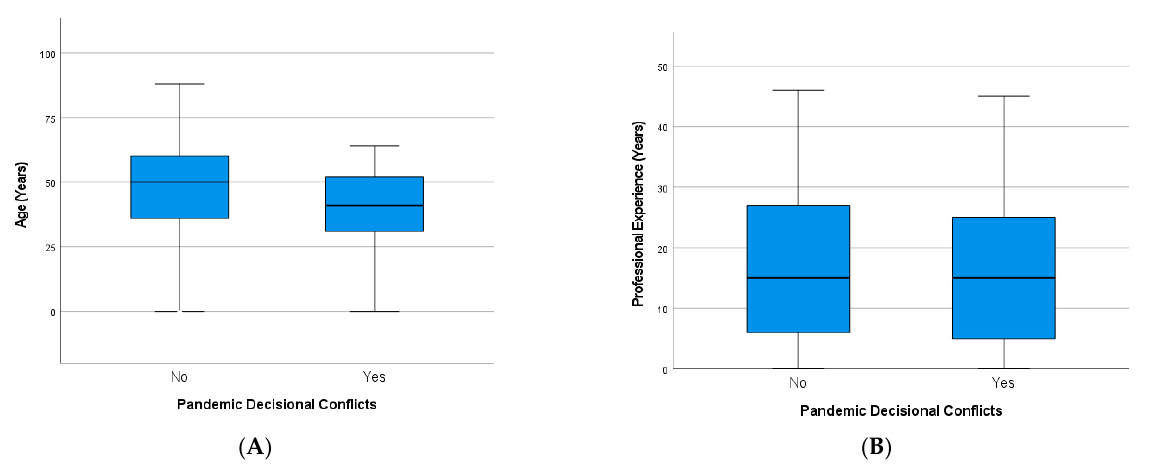
Figure 4. Factors of vulnerability to decisional conflicts of healthcare professionals during the pandemic: ( A ) age ( p < 0.001) and ( B ) professional experience (n.s.).